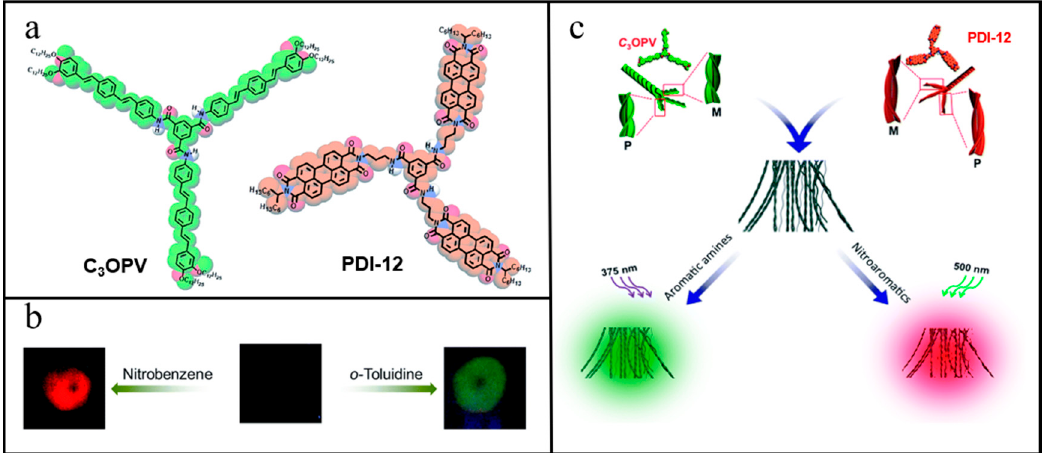
Figure 13. ( a ) Chemical structures and molecular models (shown in color) of C 3 OPV and PDI-12; ( b ) Photographs showing the fluorescence of a film fabricated from 1:1 mixture of before and after exposure to nitrobenzene and o -toluidine vapor, leading to turn-on of the fluorescence of PDI-12 and C 3 OPV, respectively; ( c ) Schematic illustration of the fluorescence ‘turn-on’ mechanism of the self-sorted fibers of a 1:1 mixture of C 3 OPV and PDI-12 upon exposure to two different types of VOCs, electron donor like amines and electron acceptor like nitroaromatics [77].